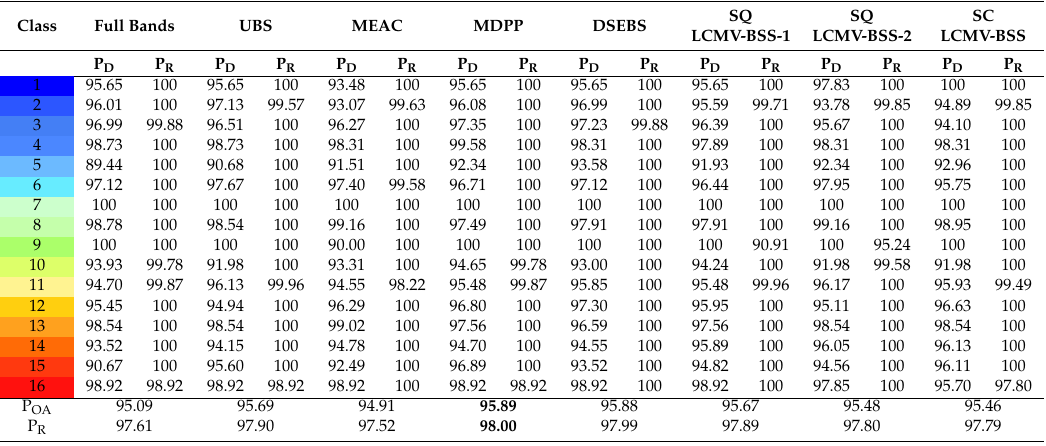
Table 3. P D , P OA , and P R calculated from the classification results in Figure 4 for Purdue’s data.